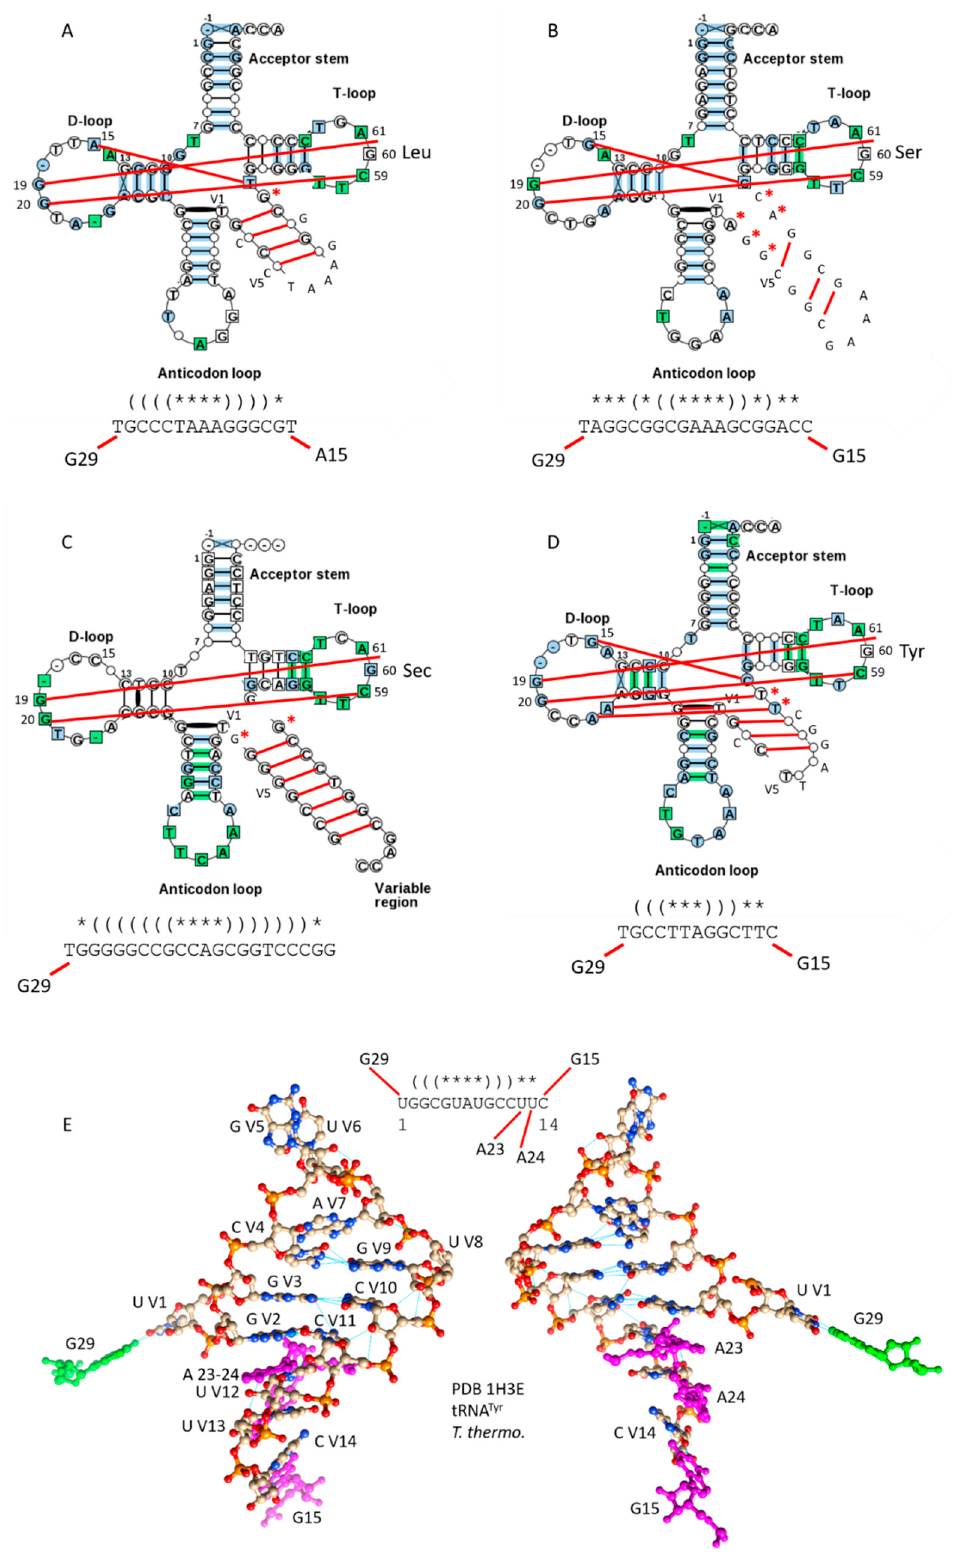
Figure 5. Typical type-II tRNAs in bacteria. ( A ) Bacterial tRNA Leu . ( B ) Bacterial tRNA Ser . ( C ) tRNA Sec . ( D ) tRNA Tyr . Some interactions within the D loop, V loop and T loop are indicated with red lines. Red asterisks indicate V loop bases that are not part of the V loop stem, and may allow discrimination of different V loops (i.e., by LeuRS, SerRS and other aaRS enzymes). ( E ) The tRNA Tyr V loop from Thermus thermophilus (two views).